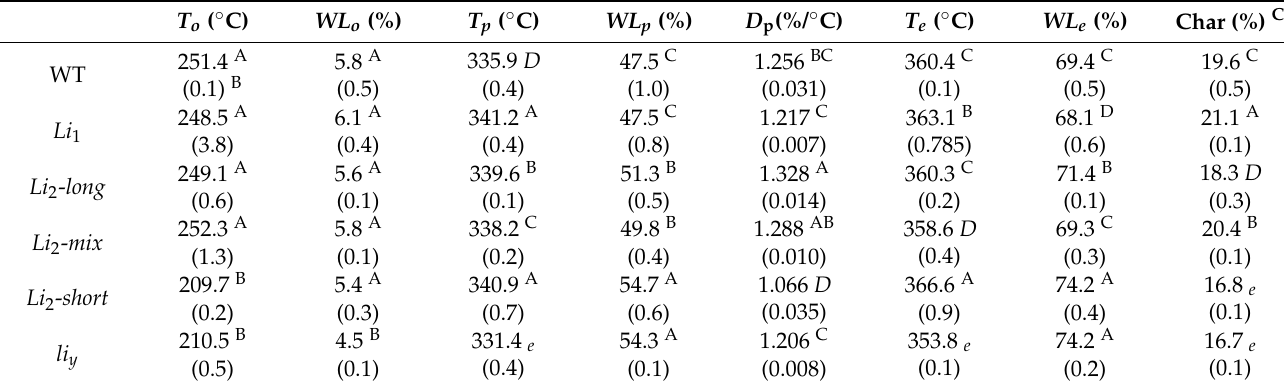
Table 2. Comparison of thermogravimetric data from the TG and DTG analysis.